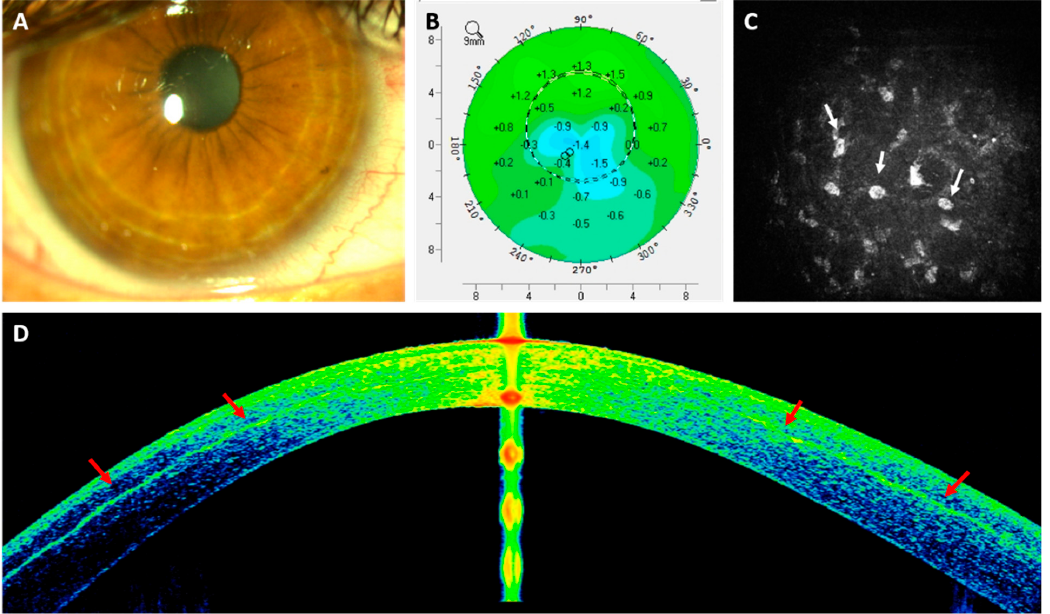
Figure 3. Autologous h-ADSCs corneal stroma implantation for advanced keratoconus. ( A ) Slit lamp picture 24 h after the procedure; ( B ) Topographic changes (Pentacam) between preop and 6 months after surgery. Observe the overall stability of the keratometric parameters; ( C ) Corneal con- focal biomicroscopy pictures at the surgical plane in the first postoperative month. Stem cell survival is confirmed by the presence of cells showing a more rounded morphology (white arrows) (image corresponds to an area of 0.1 mm 2 ); ( D ) AS-OCT picture 6 months postoperatively. Note the patched hyper-reflective areas (red arrows) at the level of the stromal pocket compatible with areas of new collagen production.